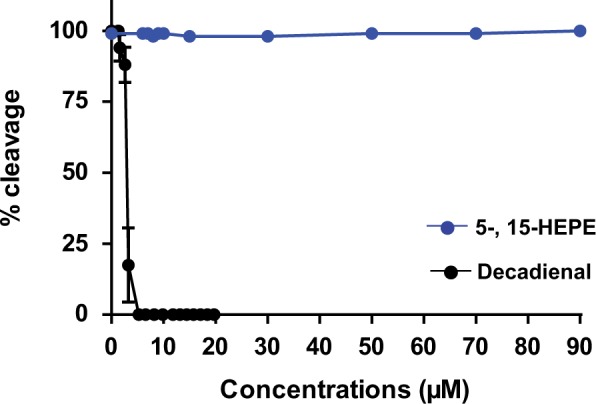
Cleavage inhibition in sea urchin embryos following decadienal (at the concentrations of 1.3, 1.6, 2.6, 3.3, 5.3, 6.6, 8.2, 9.9, 11.8, 13.1, 14.5, 15.8, 17.1, 18.4, and 19.7 μM; black line; data from Romano et al., 2010) and 5- and 15-HEPE (at the concnetrations of 6, 7, 8, 9, 10, 15, 30, 50, 70 and 90 μM; blue line) treatments. Control is reported as 0 μM concentration. Abbreviation: HEPE, hydroxyacids.